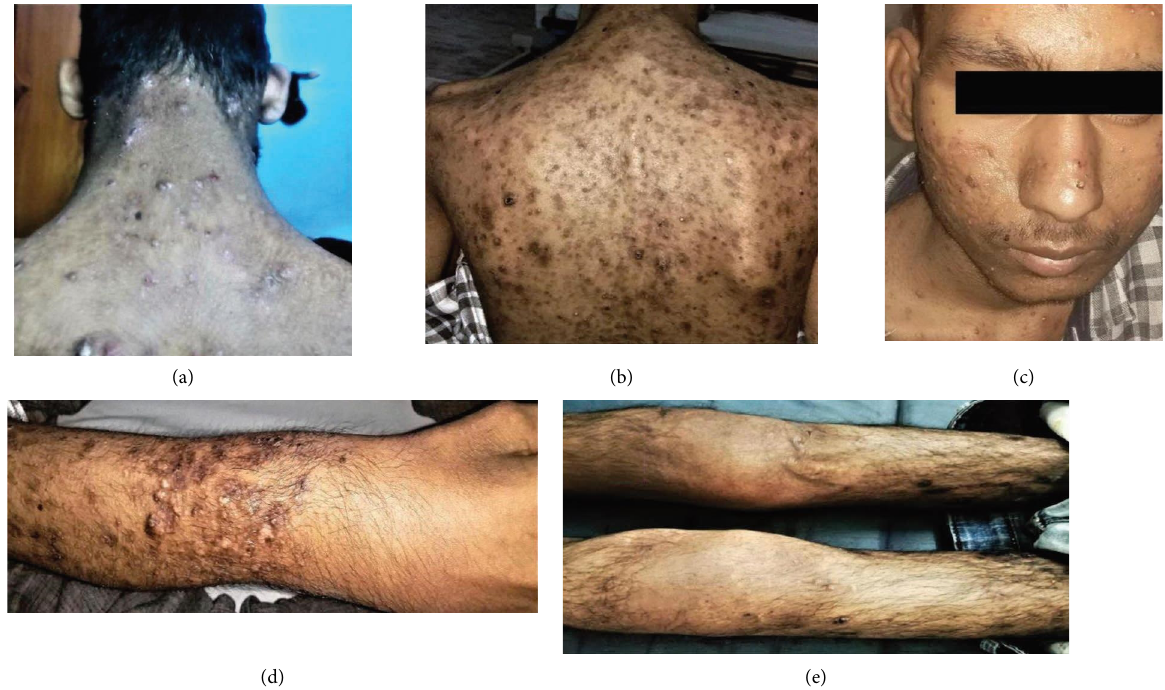
Figure 1: (a) Multiple pustular acne over back, (b) acnes healing with hyperpigmentation and scar, (c) few acnes with oily skin of face (d) pustular rashes over forearm with wrist synovitis and bony swelling, (e) active synovitis in knee with black pustules on